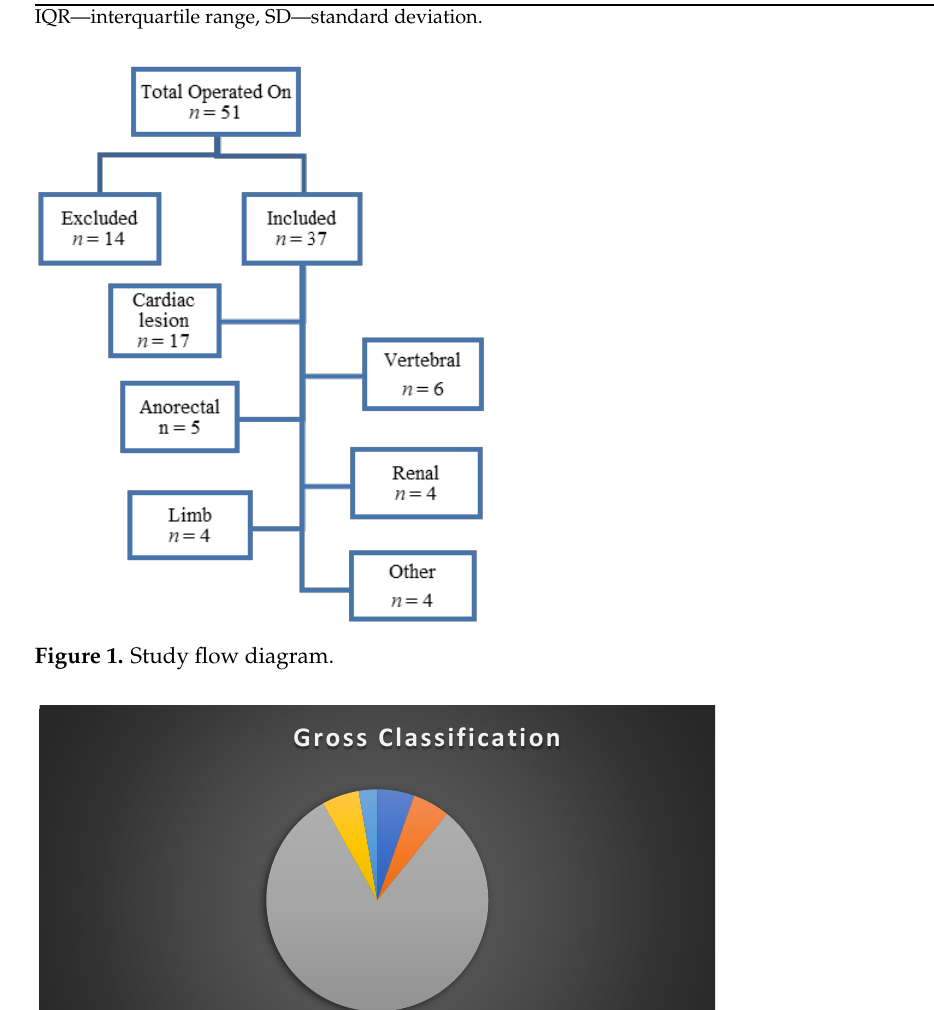
Table 2. Congenital abnormalities among neonates presenting for TOF repair.